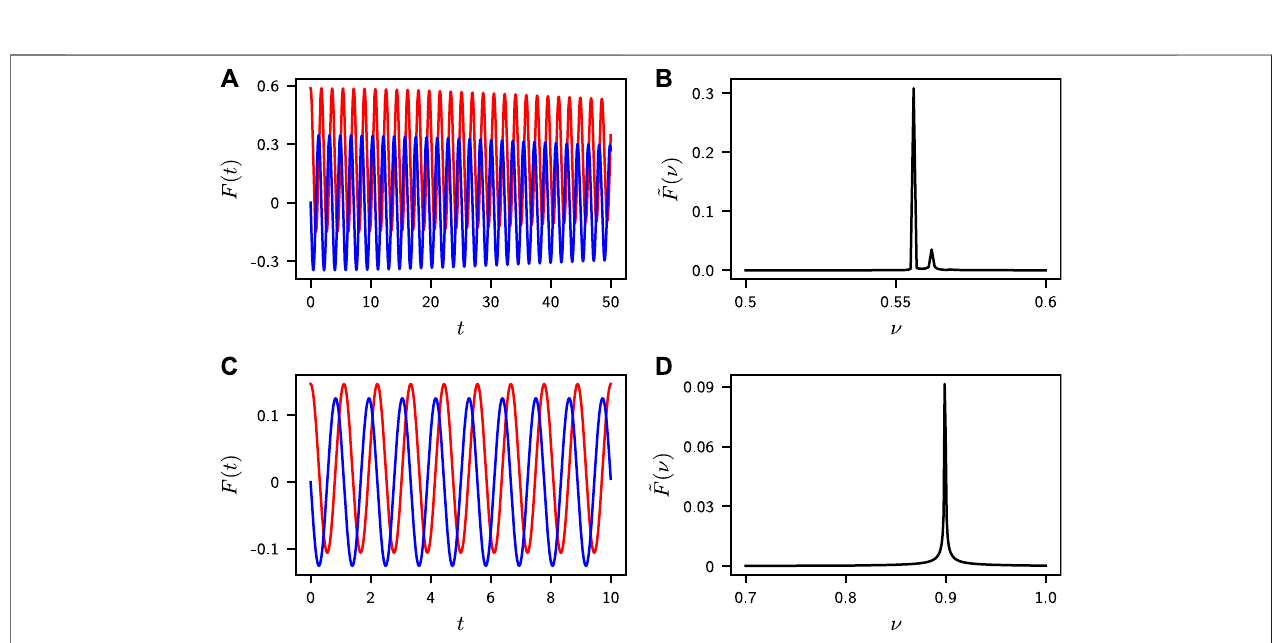
FIGURE 6 | F ( t ) as a function of time t at q = 3 for ferromagnetic interaction (A) and q = 2 for antiferromagnetic interaction (C) . The red and blue solid lines, respectively, correspond to Re( F ) and Im( F ). The Fourier transform spectrum ~ F ( ] ) of Re( F ) or Im( F ) with ] = 1/ T the frequency, T the period, for ferromagnetic (B) and antiferromagnetic (D) interactions, at temperature β = 1 and system size N =